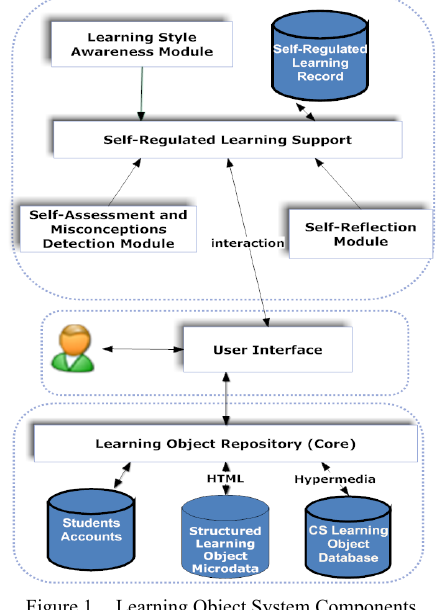
Figure 1. Learning Object System